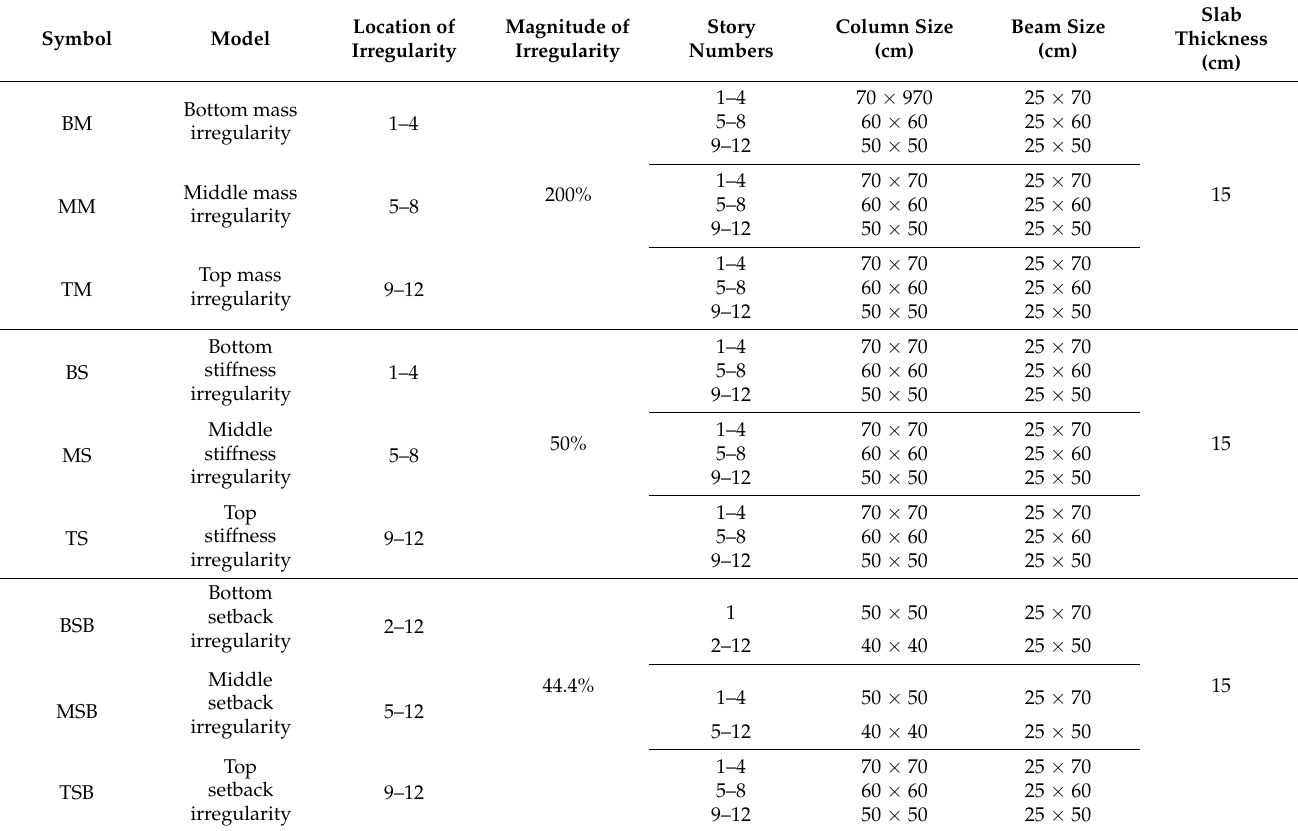
Table 2. Description of irregularities and cross-sectional dimensions for the investigated